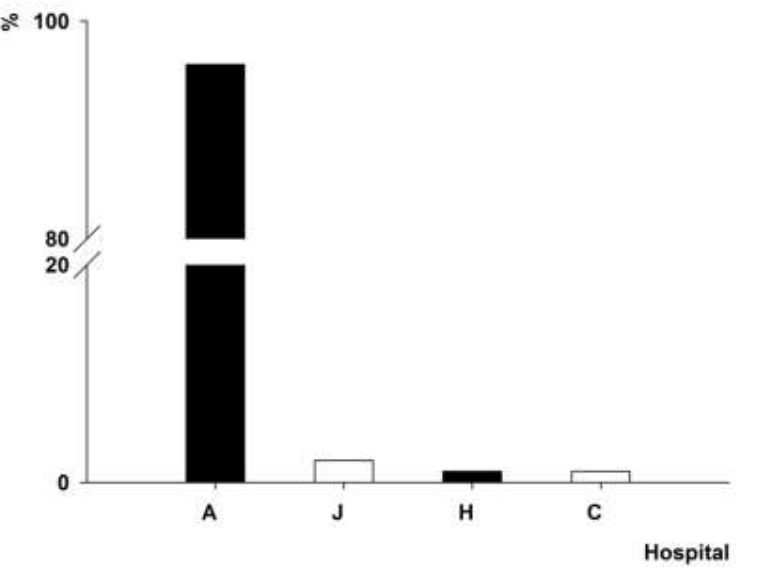
Figure 4. Distribution of A. baumannii isolates with PFGE genotype